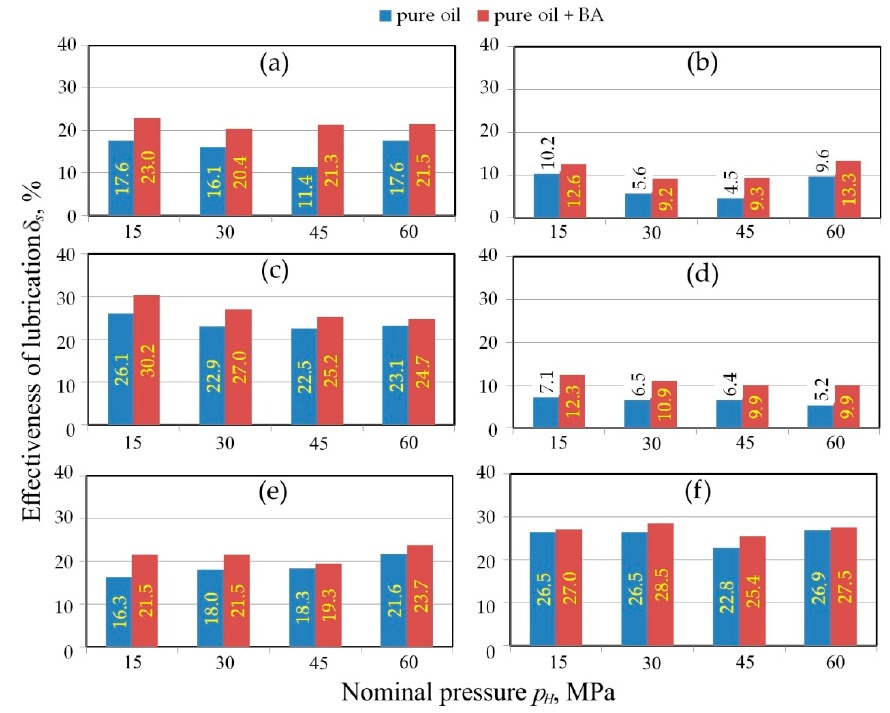
Figure 11. Comparison of the effectiveness of lubrication for tests carried out under the range of nominal pressure between 15 and 60 MPa and roll roughness of Ra = 0.32 mm for different oils: ( a ) linseed, ( b ) olive, ( c ) palm, ( d ) rapeseed, ( e ) soybean, ( f ) sunflower.